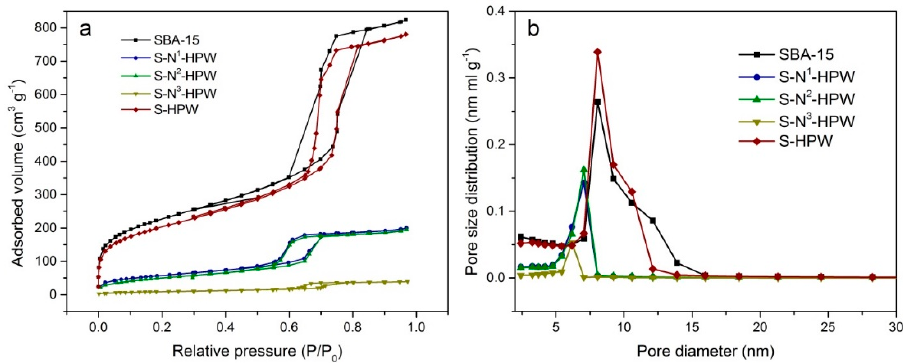
Figure 2. N 2 adsorption-desorption isotherms ( a ) and the corresponding pore size distributions ( b ) of SBA-15, S-N x -HPW, and S-HPW materials.